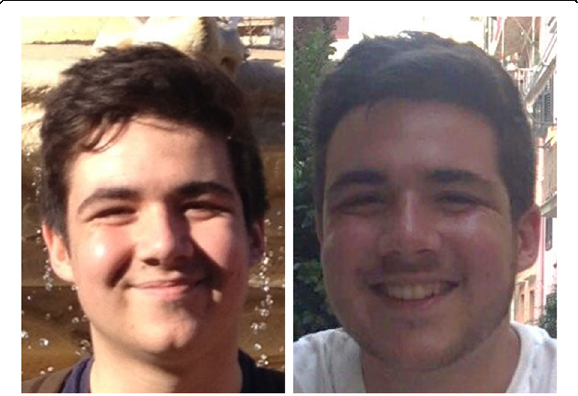
Fig. 2 A sample pair from the PMT. The two identities differ in this trial. Due to issues with image permissions, this figure only displays images that resemble those used in the actual